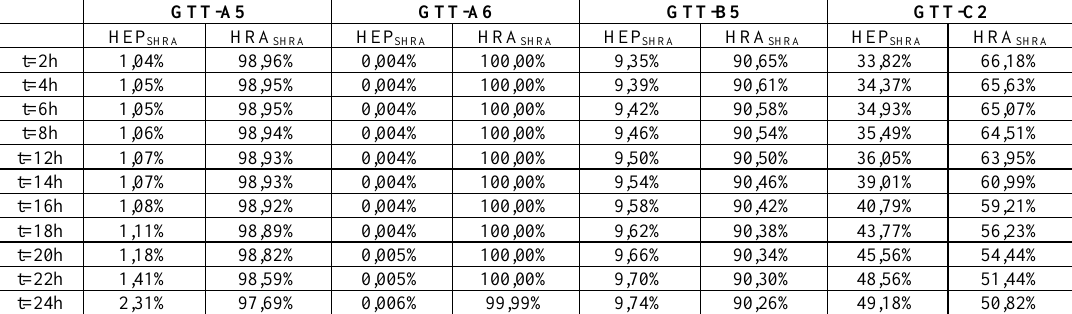
Table 9. HEP SHRA vs HRA SHRA .